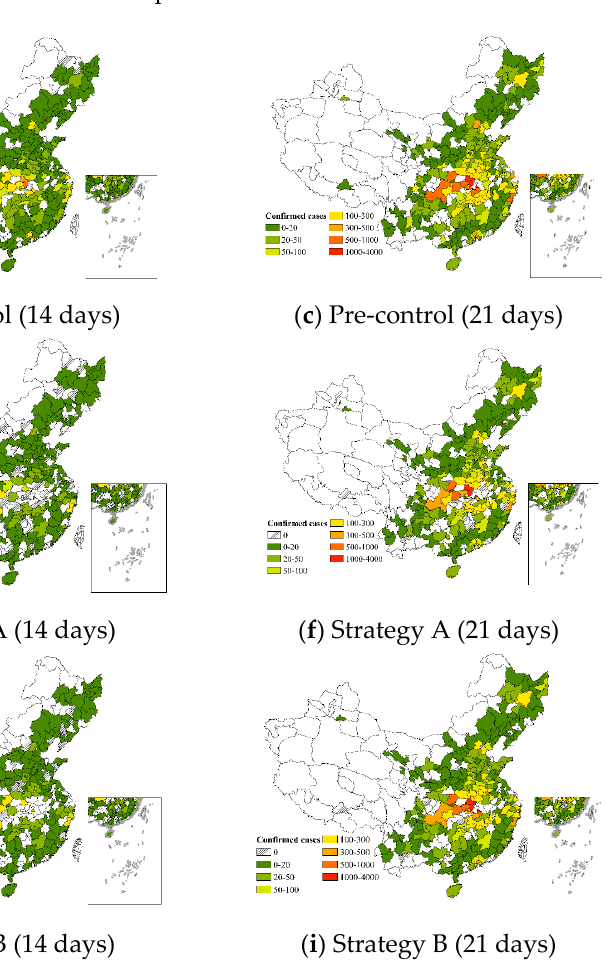
Figure 6. Changes in the epidemic under different strategies. Table 8. Control effects of Strategy